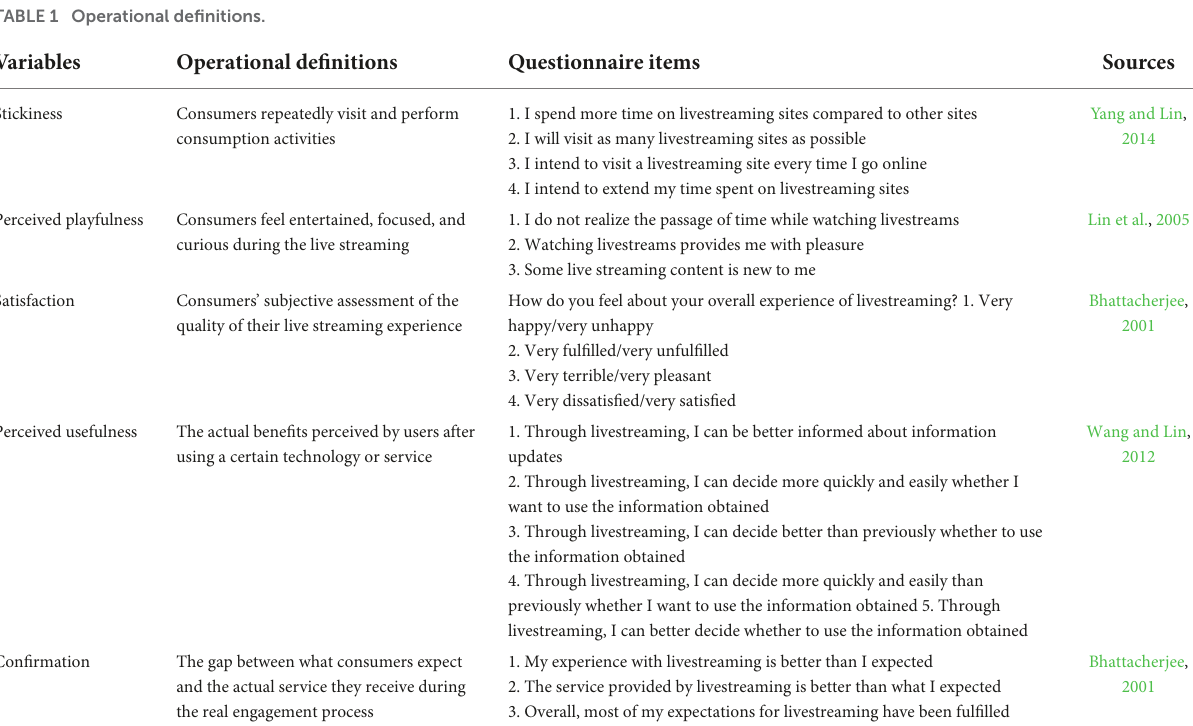
FIGURE1 Research model.